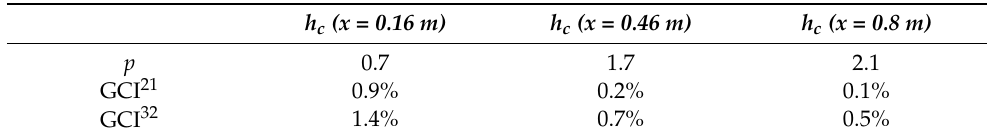
Table A1. Convergence orders and GCI values.